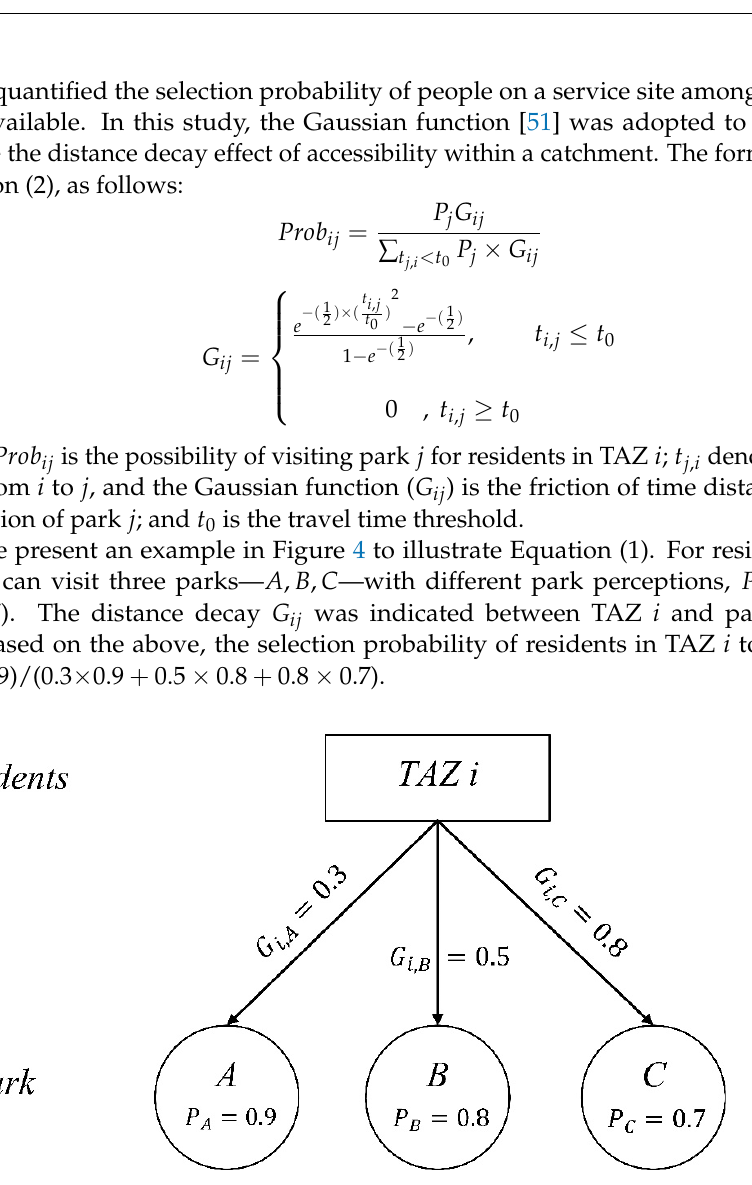
Figure 4. An example of selection probability with park perceptions and distance decay.